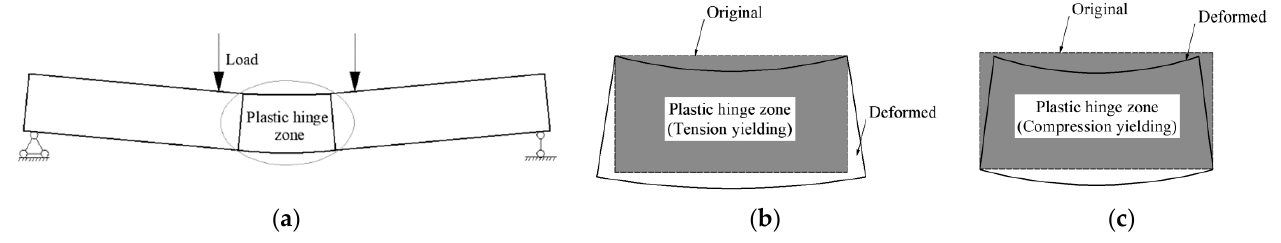
Figure 1. Plastic hinge mechanism [10]. ( a ) Plastic hinge zone in the flexural structure, ( b ) conven- tional RC member, ( c ) CY member.